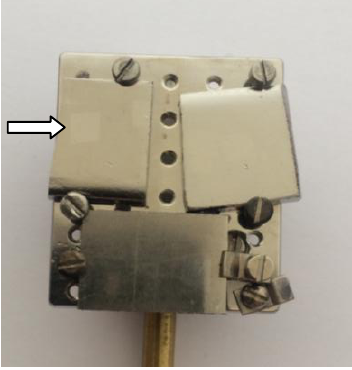
Figure 8. Holder with three Nb samples fixed onto it: EP—up on the left side, and MEP—up on the right side, and AR—down below. Well visible crater 3.5 mm × 3.5 mm, as marked by arrow, appears on EP niobium sample.